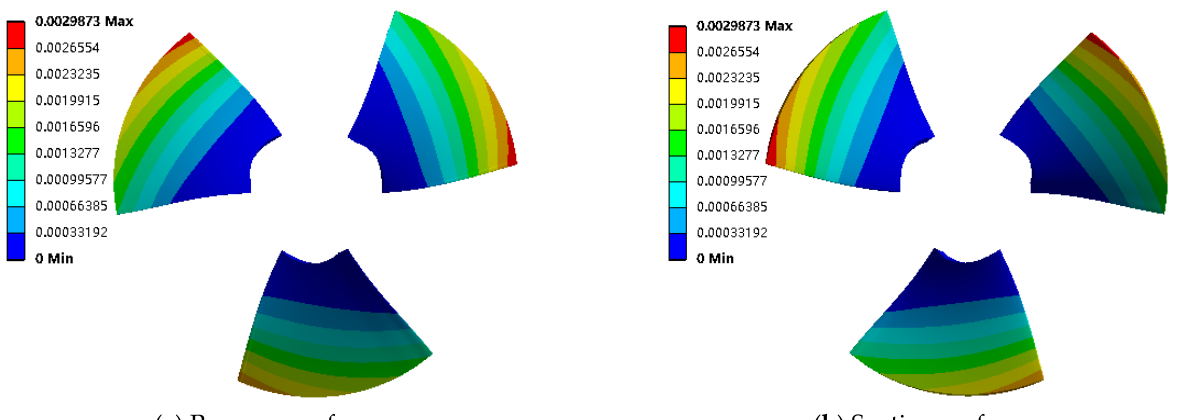
Figure 18. Q = 20 m 3 /s Deformation of impeller, Unit: m.